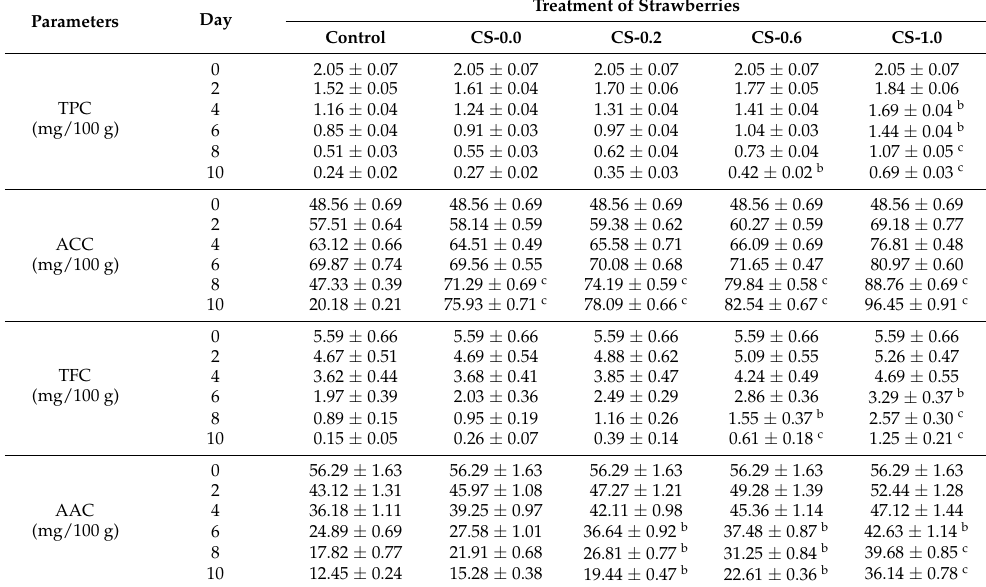
Table 4. The influence of CS films containing PFEO on the total phenolic content (TPC), total flavonoid content (TFC), anthocyanin content (ACC), and ascorbic acid content (AAC) of strawberries refrigerated at 4 ◦ C for 10 days a